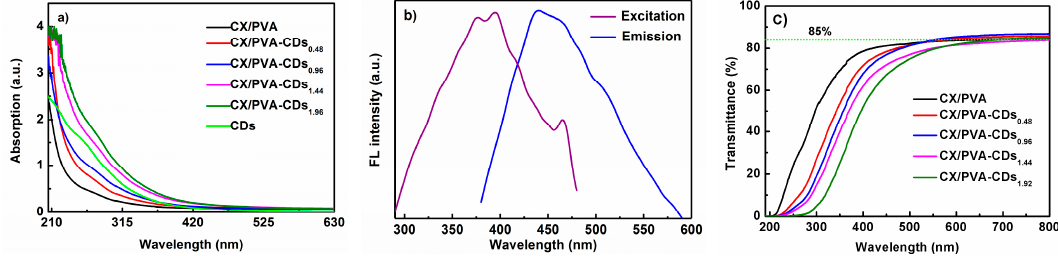
Figure 6. ( a ) Absorption spectra of CX / PVA and CX / PVA-CDs films; ( b ) fluorescence spectra of CX / PVA-CDs 1.92 ; ( c ) transmittance spectra of CX / PVA and CX / PVA-CDs films.